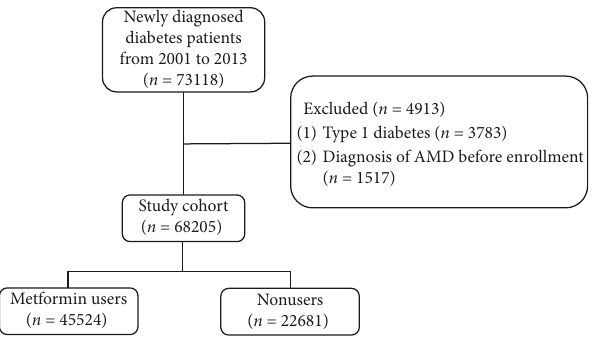
Figure 1: Flow chart showing the procedures in selecting the participants into the study. AMD: age-related macular